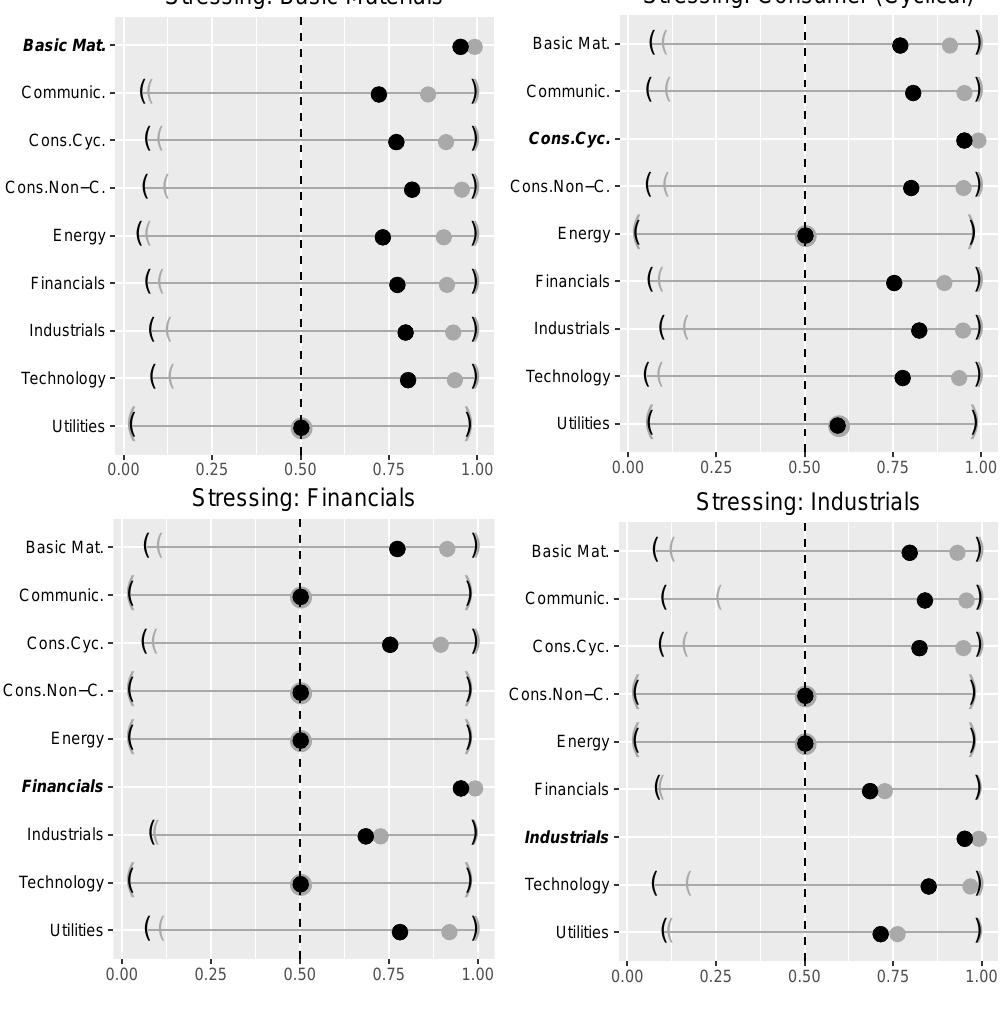
Figure 4. Stress testing results for selected industry sectors. In each plot, the sector written in bold italics is stressed at levels 95% (black) and 99% (gray). The brackets indicate the 95% prediction